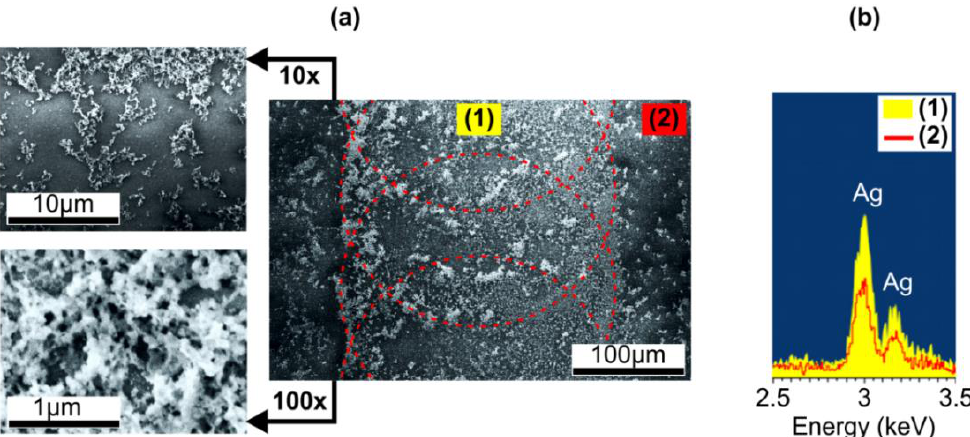
Figure 2. ( a ) SEM images of the ion-exchanged glass surface irradiated with IR ns-laser at 6.3 mJ and 2 Hz pulses after removal of ~25-nm glass layer via chemical etching. The outlines schematically show mutual position of the irradiation spots. Left panels: SEM images of higher resolution. ( b ) EDS spectra in (1) laser-irradiated and (2) non-irradiated regions on the glass surface after chemical